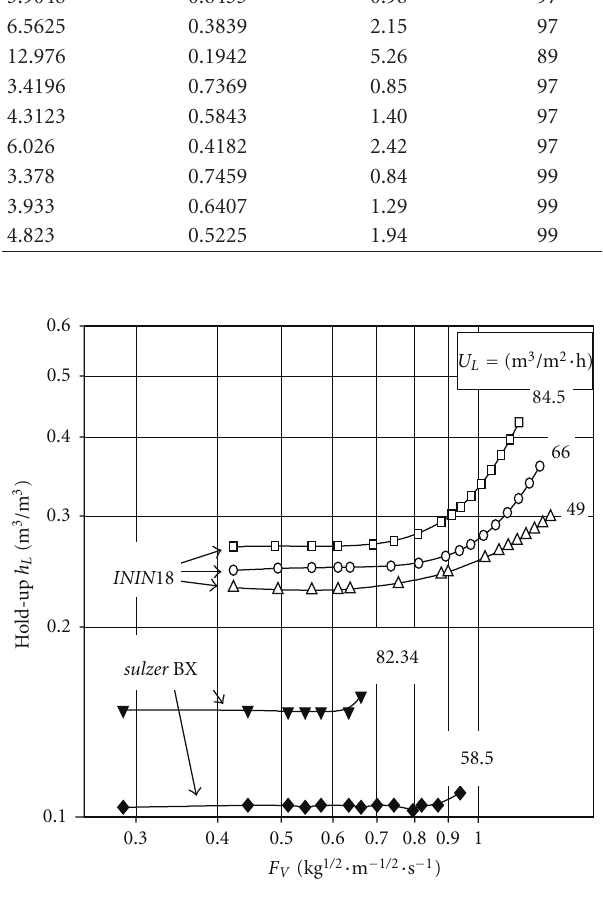
Figure 2: Liquid hold-up versus the gas capacity factor.